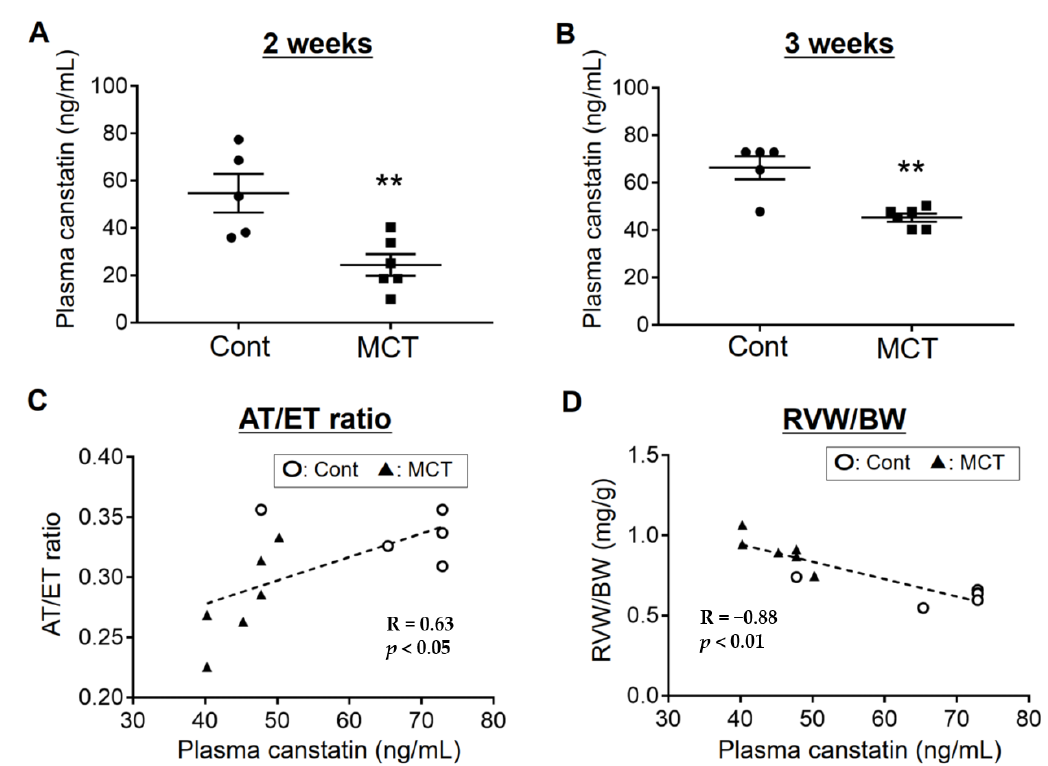
Figure 1. Expression level of canstatin in plasma was decreased and correlated with severity in a rat model of monocrotaline-induced pulmonary arterial hypertension (PAH). Eight-week-old male Wistar rats were intraperitoneally injected with saline (Cont) or monocrotaline (60 mg / kg, MCT). ( A , B ) Two ( A ) or three ( B ) weeks later, blood samples were collected and plasma was obtained. Plasma canstatin level was measured by sandwich enzyme-linked immunosorbent assay (ELISA). The concentration of plasma canstatin was shown as scatter plots of individual data points and mean ± standard error of the mean (S.E.M.) (Cont: n = 5, MCT: n = 6). ** p < 0.01 vs. Cont. ( C , D ) Relationship between plasma concentration of canstatin and acceleration time (AT) / ejection time (ET) ratio ( C ) or right ventricular (RV) weight (RVW) / body weight (BW) ratio ( D ) was shown as scatter plots of individual data points (Cont: n = 5, MCT: n = 6). Pearson’s correlation coe ffi cient analysis was performed to evaluate the relationship. R: correlation coe ffi